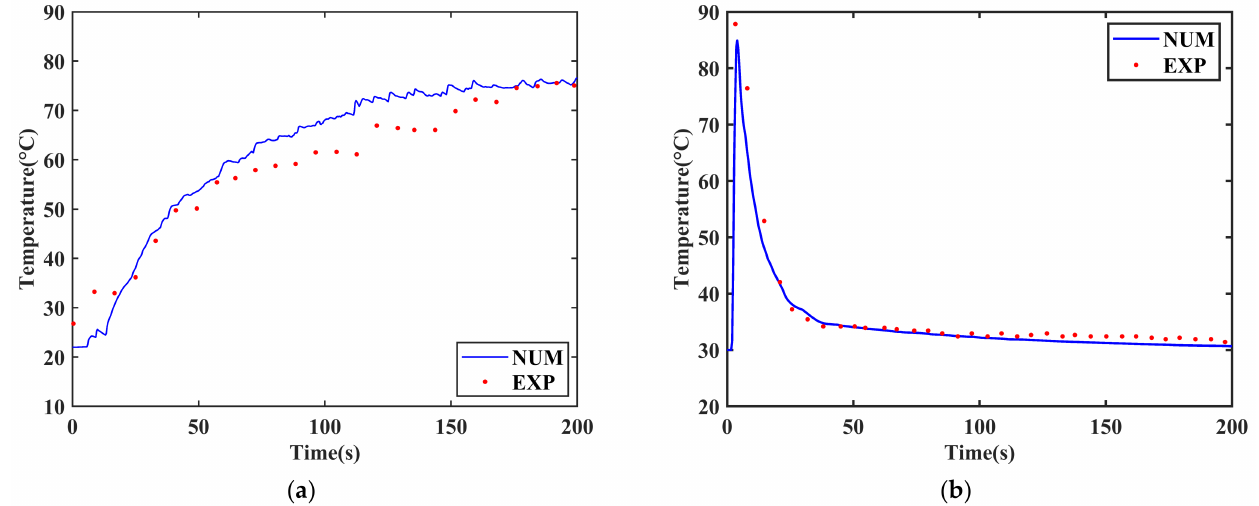
Figure 4. Validation of the numerical model against experimental results ( a ) ceiling location 0.5 m away from the centre without suppression and ( b ) at 1.8 m above the ground during